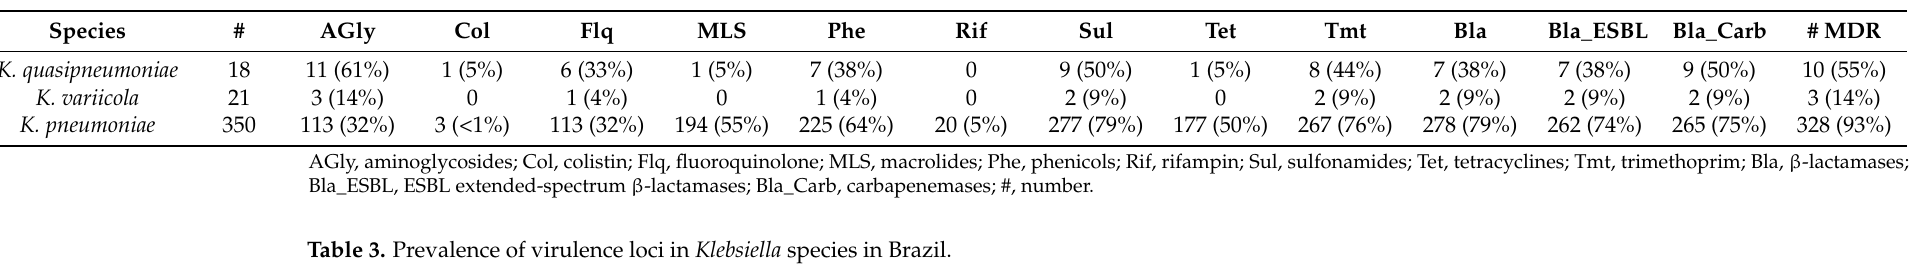
Table 2. Number of Klebsiella genomes carrying antibiotic resistance genes to different classes of antibiotics per species.